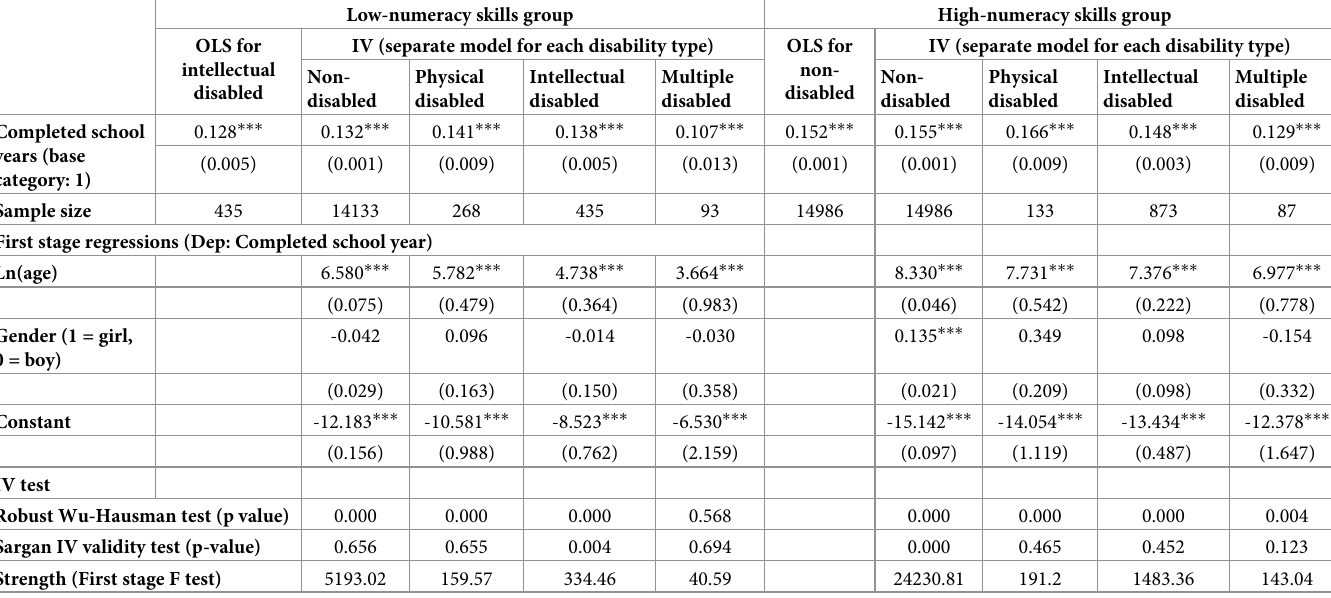
Table 5. Regressions on the mean numeracy score in low- and high-numeracy skills country